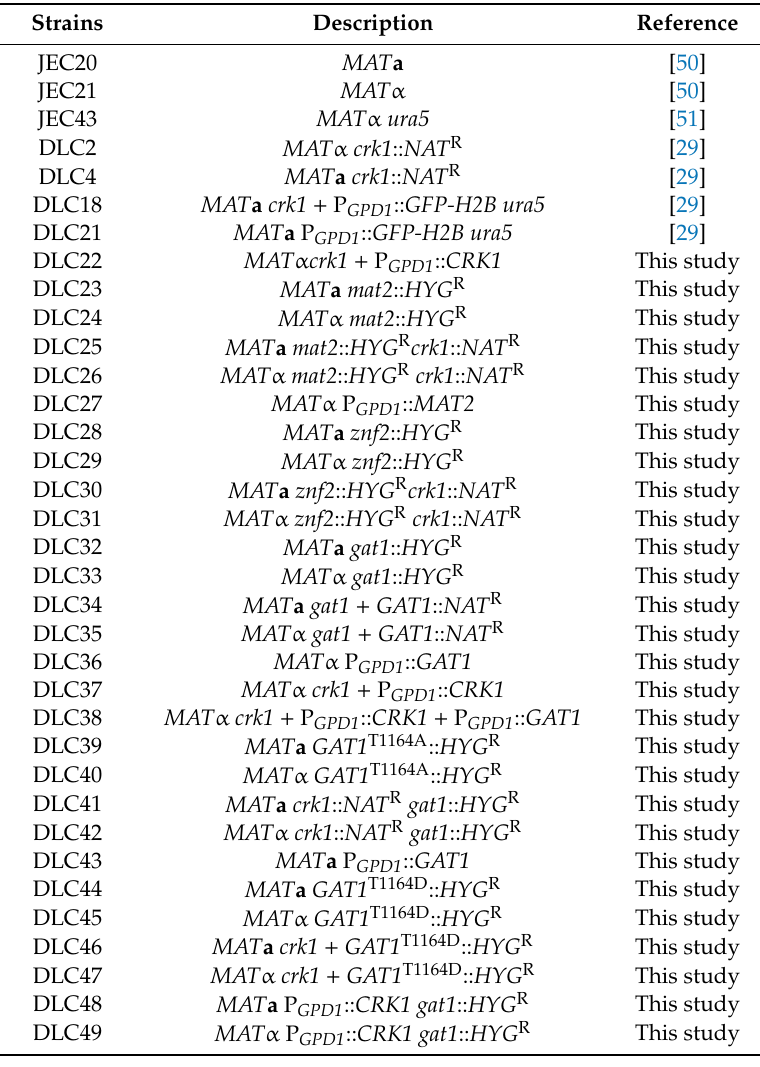
Table 1. Cryptococcus neoformans strains used in this